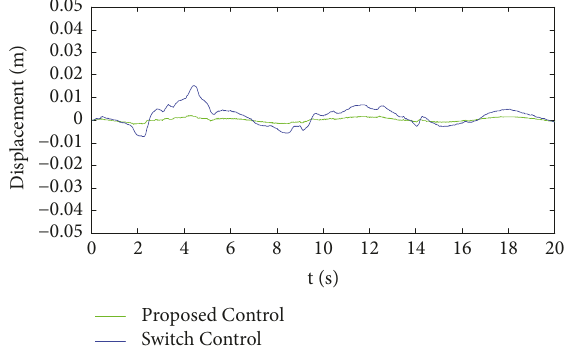
Figure 5: Displacement response of Example 2.